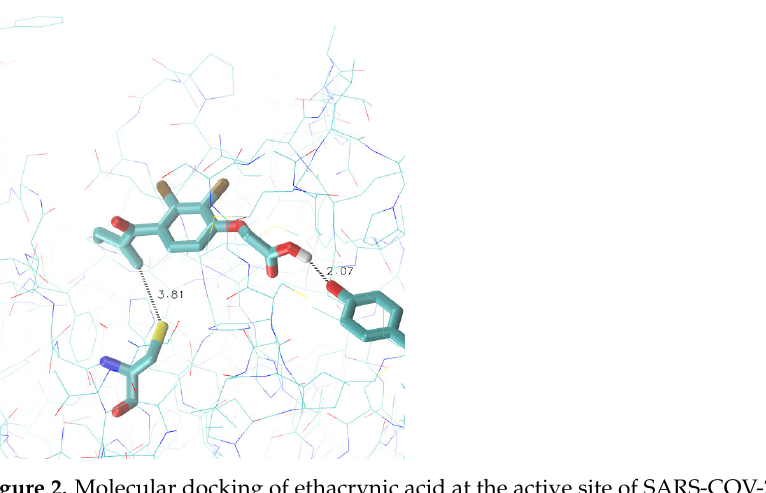
Figure 2. Molecular docking of ethacrynic acid at the active site of SARS-COV-2 M pro . The protein structure correspond to the PDB entry 6LU7. Ethacrynic acid, Cys 145 and Tyr 54 are displayed in licorice. Reported distances are in Å.